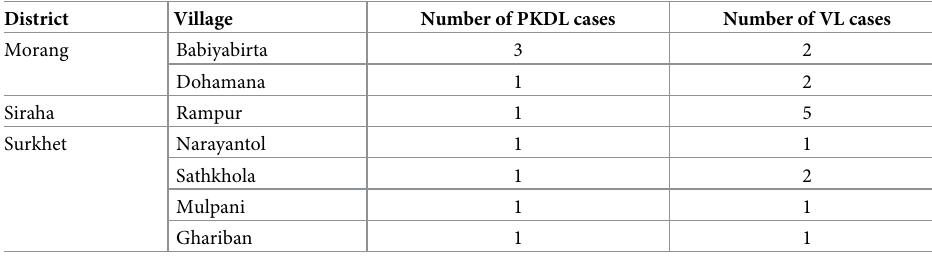
Morang per 10,000 population indicated a much larger prevalence. The clustering of cases from these two districts is likely to be due to the high L . donovani endemic areas in these dis- tricts or could also be due to propensities towards incomplete treatment [12]. Among 147 cases with skin lesion, only 9 were positive for PKDL. All suspected skin manifestations were validated by dermatologists. Beside PKDL other manifestations were mostly diagnosed as sca- bies and psoriasis. The low number of PKDL cases detected might be due to under diagnosis of PKDL by the dermatologists. Some PKDL cases may have been missed or misdiagnosed as some other skin disease. Therefore, further training of dermatologists on the differential Table 6. VL cases around PKDL cases.